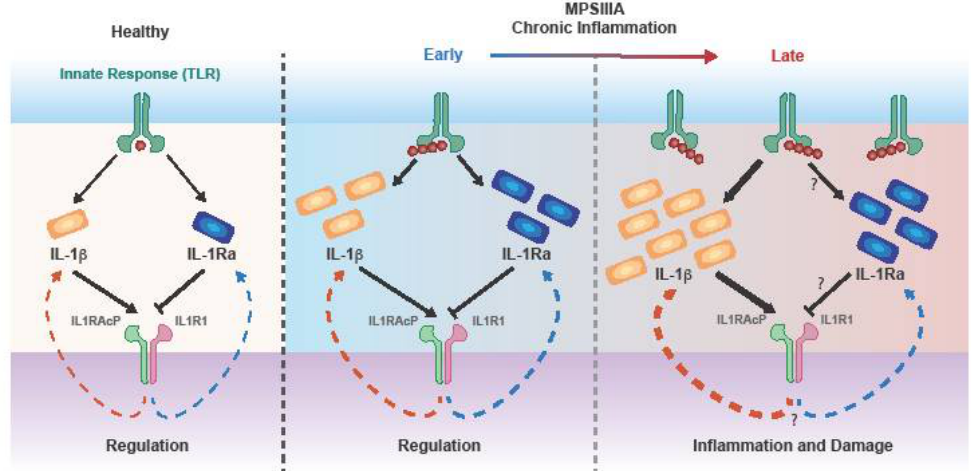
Figure 1. IL-1 feedback. Under normal conditions, TLR signalling leads to IL-1 β production. The cytokine binds to IL-1R1 which associates with the coreceptor IL1RAcP to form the high affinity interleukin-1 receptor complex. IL1 activity is modulated by the IL1-Ra, which competes for the IL1R1 binding site, preventing association with IL1RAP to form a signalling complex. Due to the spare receptor effect, higher levels of IL1-Ra are required to fully inhibit IL-1. In MPS IIIA, GAG-induced TLR4 signalling results in increased production of both cytokines. However, with disease progression, the exacerbated production of IL-1 cannot be antagonized by adequately high levels of IL-1Ra, thus determining an imbalance in the negative-feedback